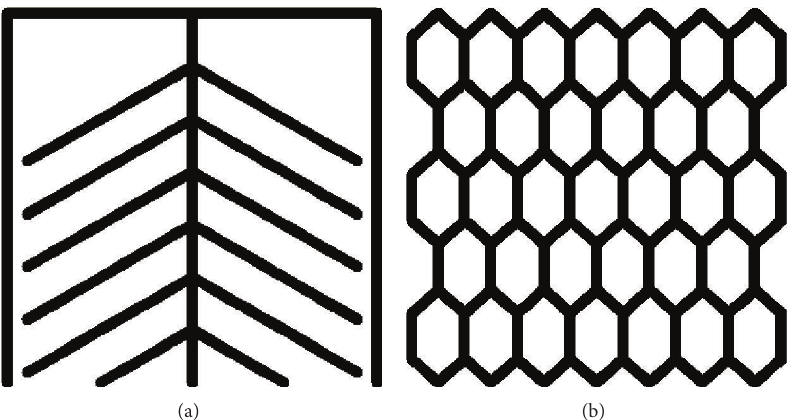
Figure 5: Geometries of poorer performance than the Standard geometry in Figure 4. (a) Nerve type and (b) honeycomb type.